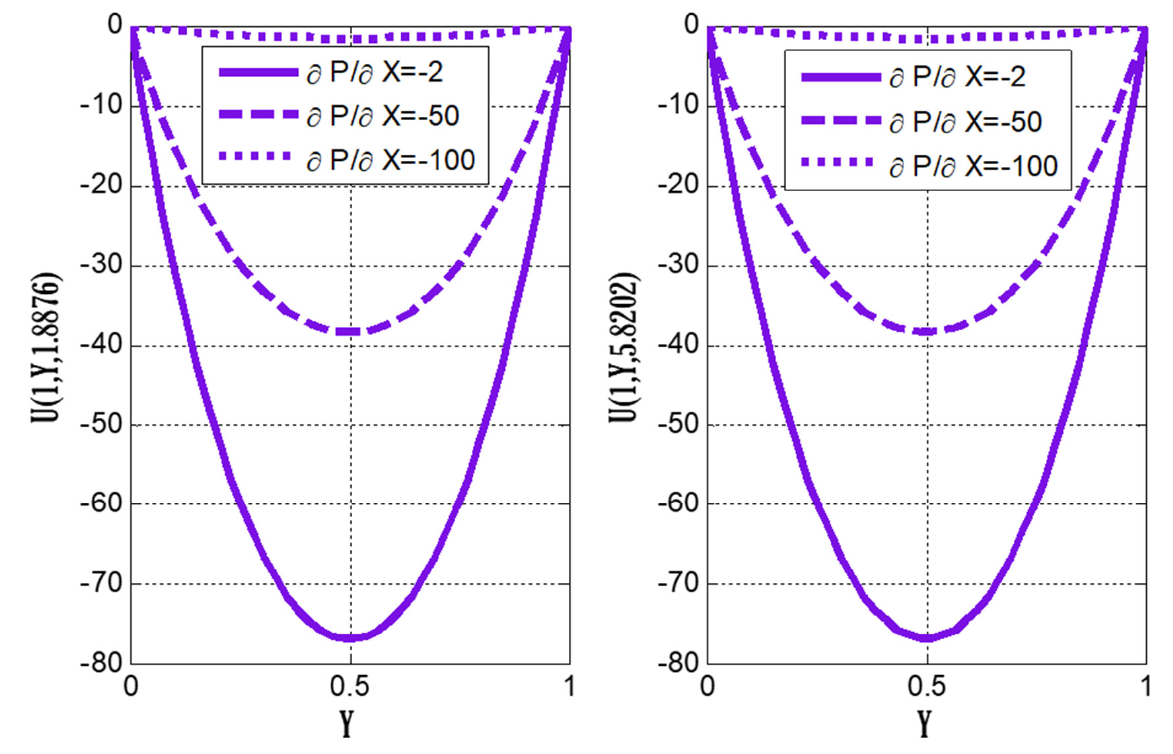
Figure 2. Impact of pressure gradient on velocity using N τ = 3000, N Y = 40, N Z = 90.